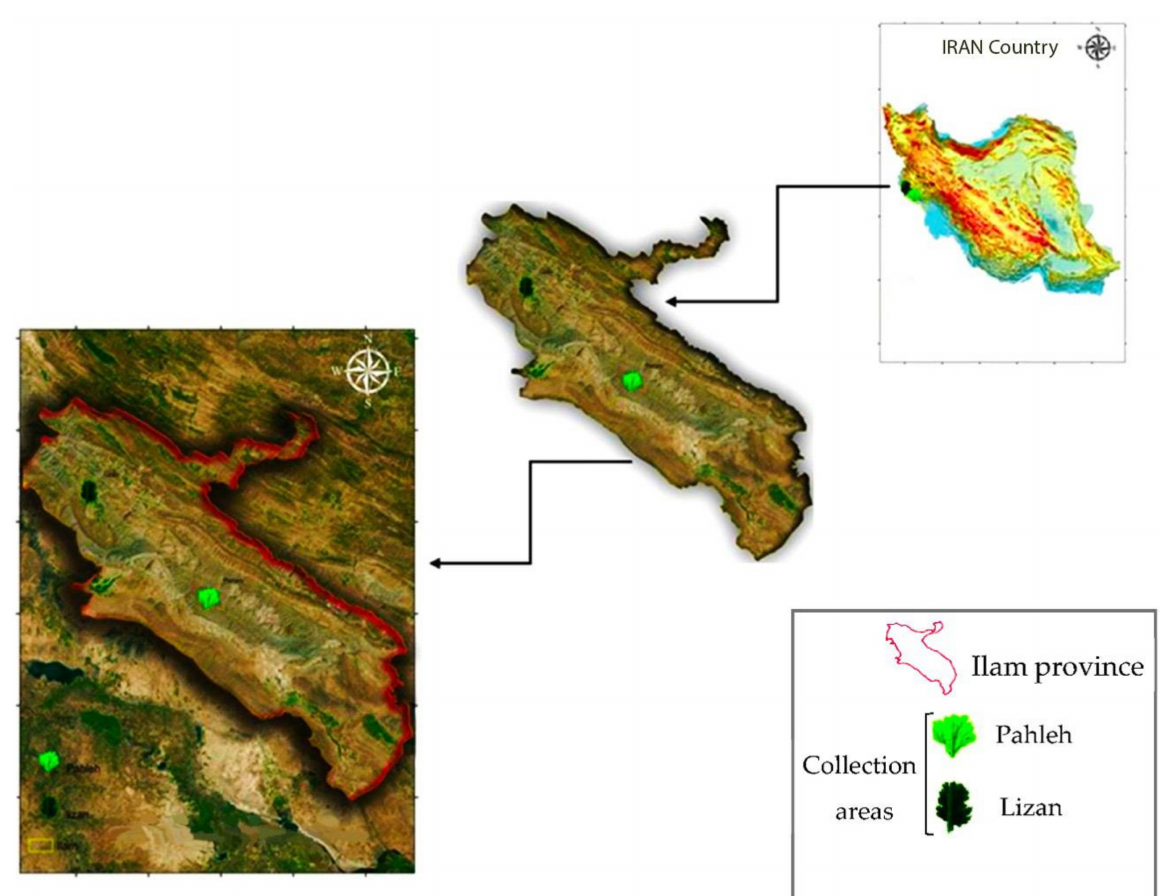
Figure 3. Different sampling locations of Scrophularia striata from Ilam province (the two sampling regions, Pahleh and Lizan, are shown in the